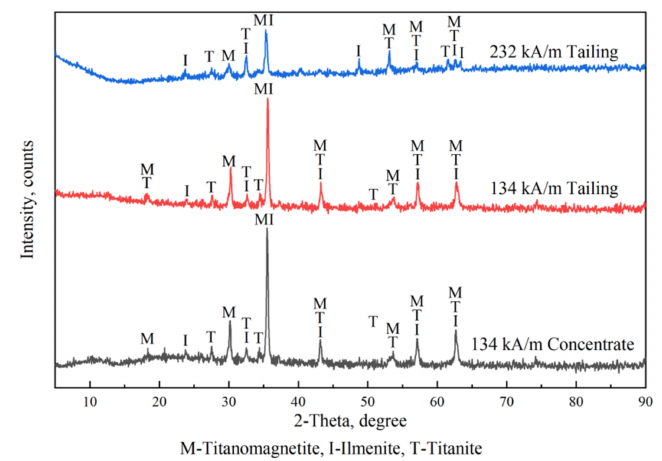
Figure 13. XRD patterns of magnetic separation products at optimal grinding time of 20